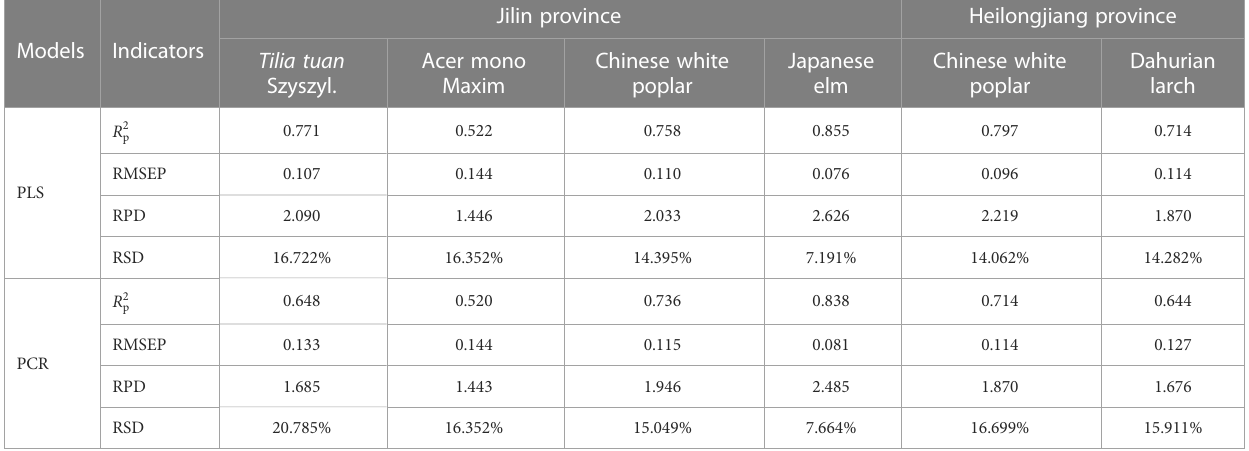
TABLE 6 The prediction results of signal models for each tree